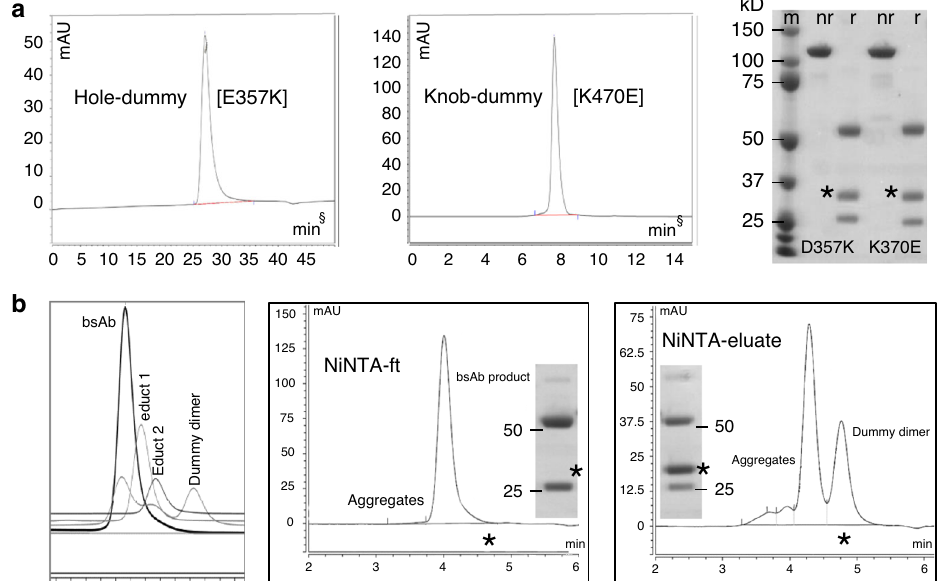
Fig. 3 Puri fi cation and characterization of FORCE educts and products. Representative examples of multiple experiments (see Section “ Methods ”— Statistics and reproducibility) show dummy-containing half-antibody-like entities and their conversion to N – N bsAbs. a SEC and SDS-PAGE analyses (nr = not reduced, r = reduced) of educts after protein-A puri fi cation from culture supernatants. § note that educts and products were initially prepared and analyzed on different SEC runs (explains differences in elution time). After method development, SEC conditions were standardized (comparable elution times in ( b ), see also Fig. 5 and Supplementary Fig. 2). * indicates the engineered dummy chain. b FORCE reaction and one-step puri fi cation of correctly assembled bsAb. Left panel: SEC differentiates educt and products of the FORCE reaction. Insets show reduced SDS-PAGE (size range between 75 and 15 kDa) of NiNTA fl ow-through and eluate. *Note the absence of the dummy chain from NiNTA-ft material and its presence in NiNTA-elutions. Source data are provided as a Source Data fi